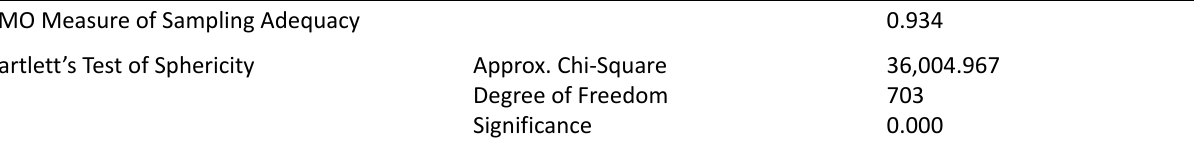
Table 3. Factor analysis validation parameters (KMO sampling adequacy and Bartlett’s test of sphericity). KMO Measure of Sampling Adequacy